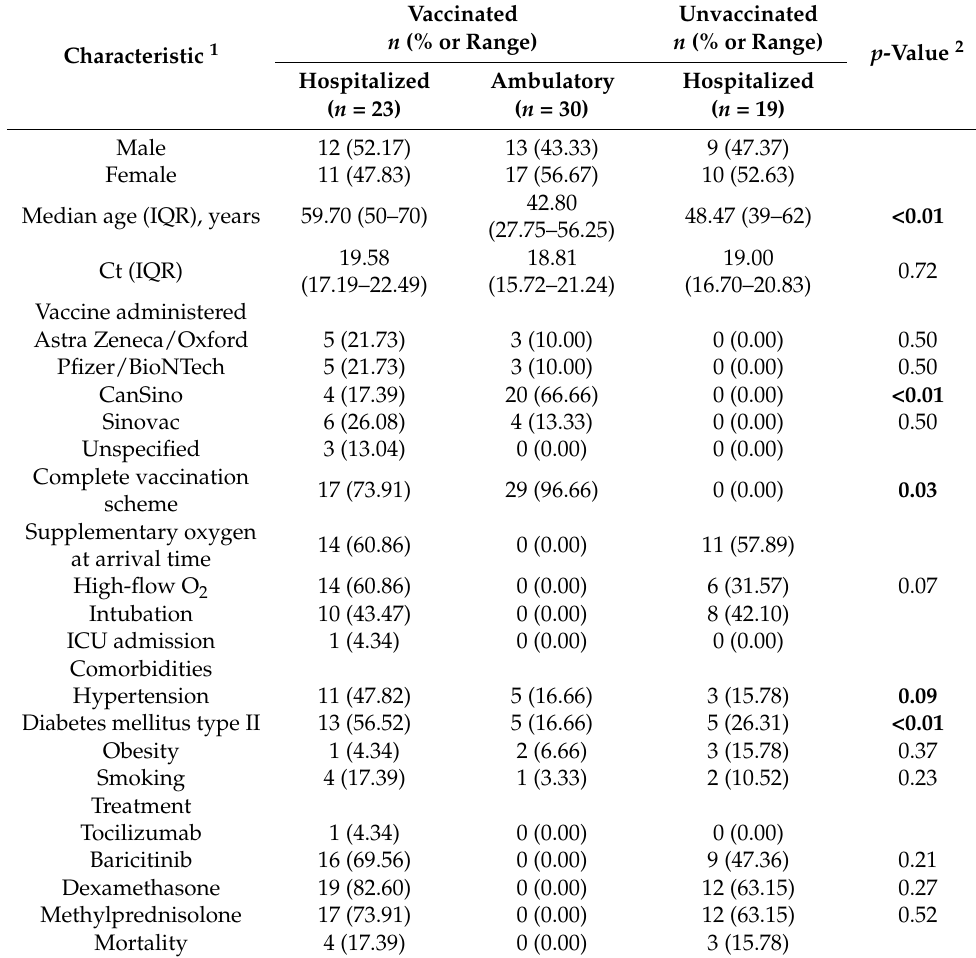
Table 1. Baseline data, comorbidities, vaccination status, and clinical intervention of patients included.